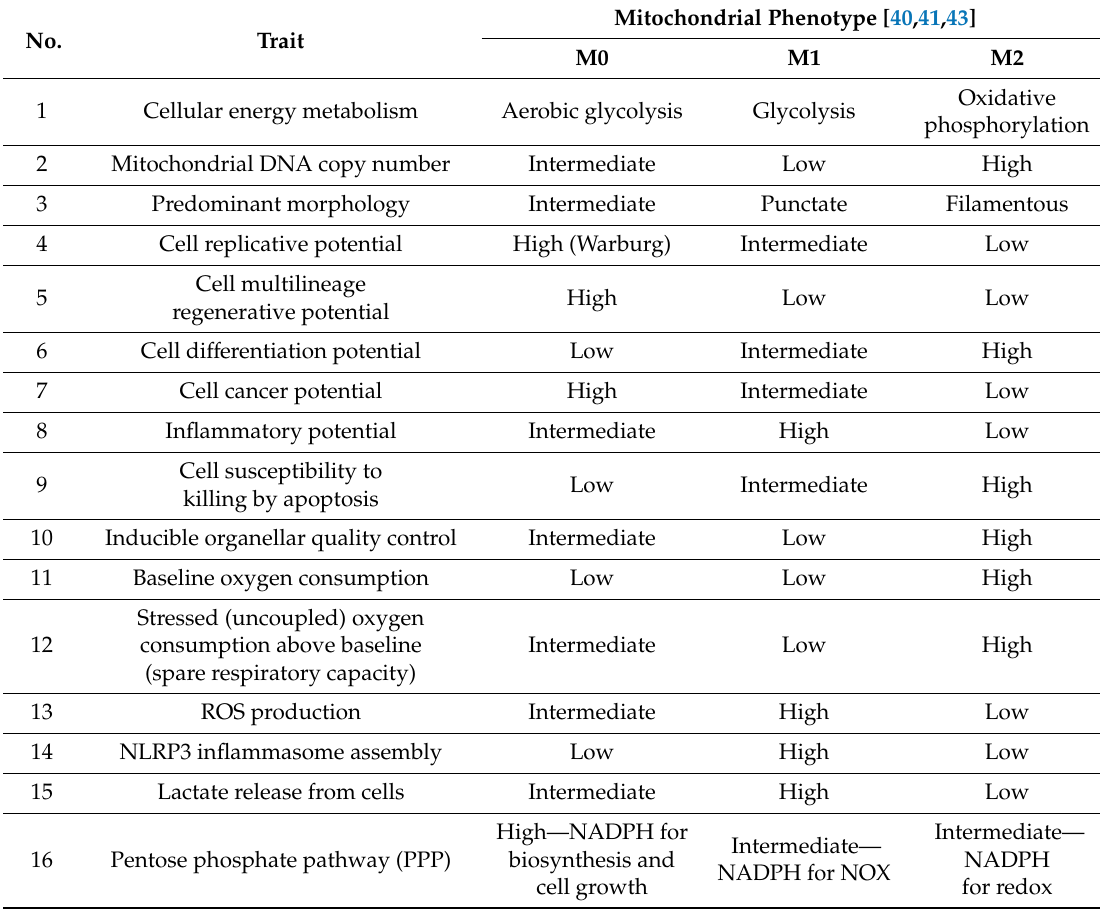
Table 1. Phenotypic characteristics of animal cell